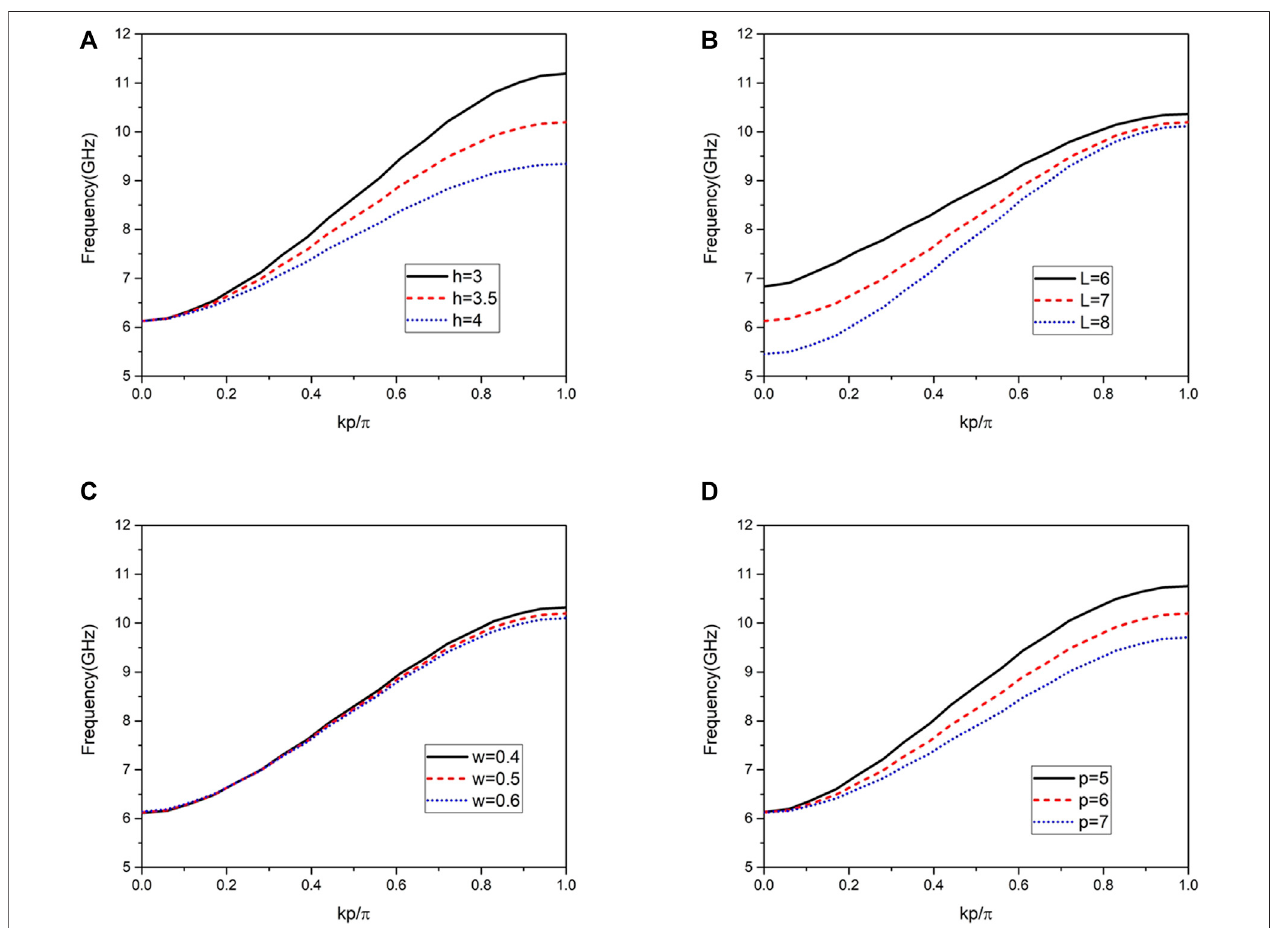
FIGURE 3 | The dispersion properties of the hybrid unit under different parameters of (A) depth of SSPP grooves h, (B) width of HMSIW L, (C) width of SSPP grooves w, and (D) interval of SSPPs p.